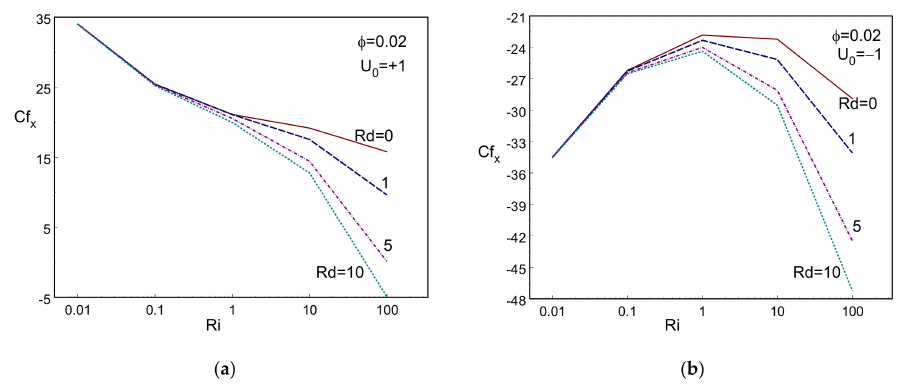
Figure 6. Drag coe ffi cient versus Ri for di ff erent Rd. ( a ) Case 1; ( b ) Case 2.